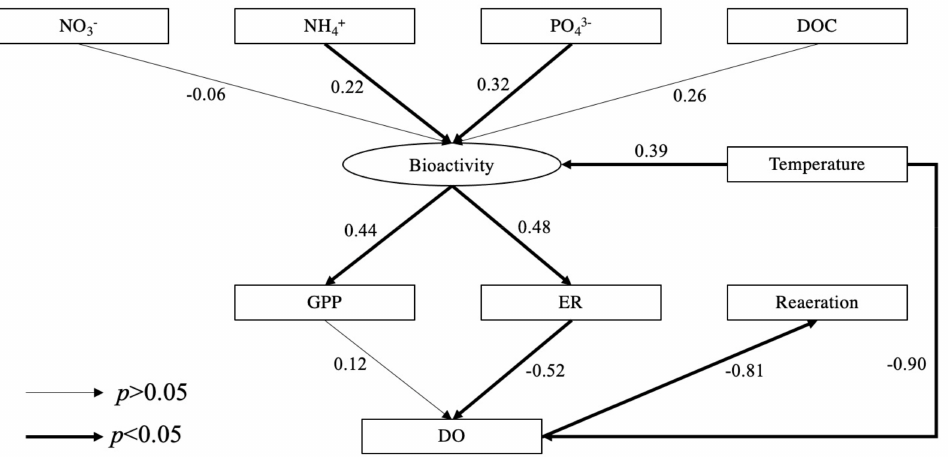
Figure 9. Standardized SEM results. The number on the arrow represents the correlation coefficient; thicker arrows indicate significant correlations. The data were obtained from all results of the three rivers during the study